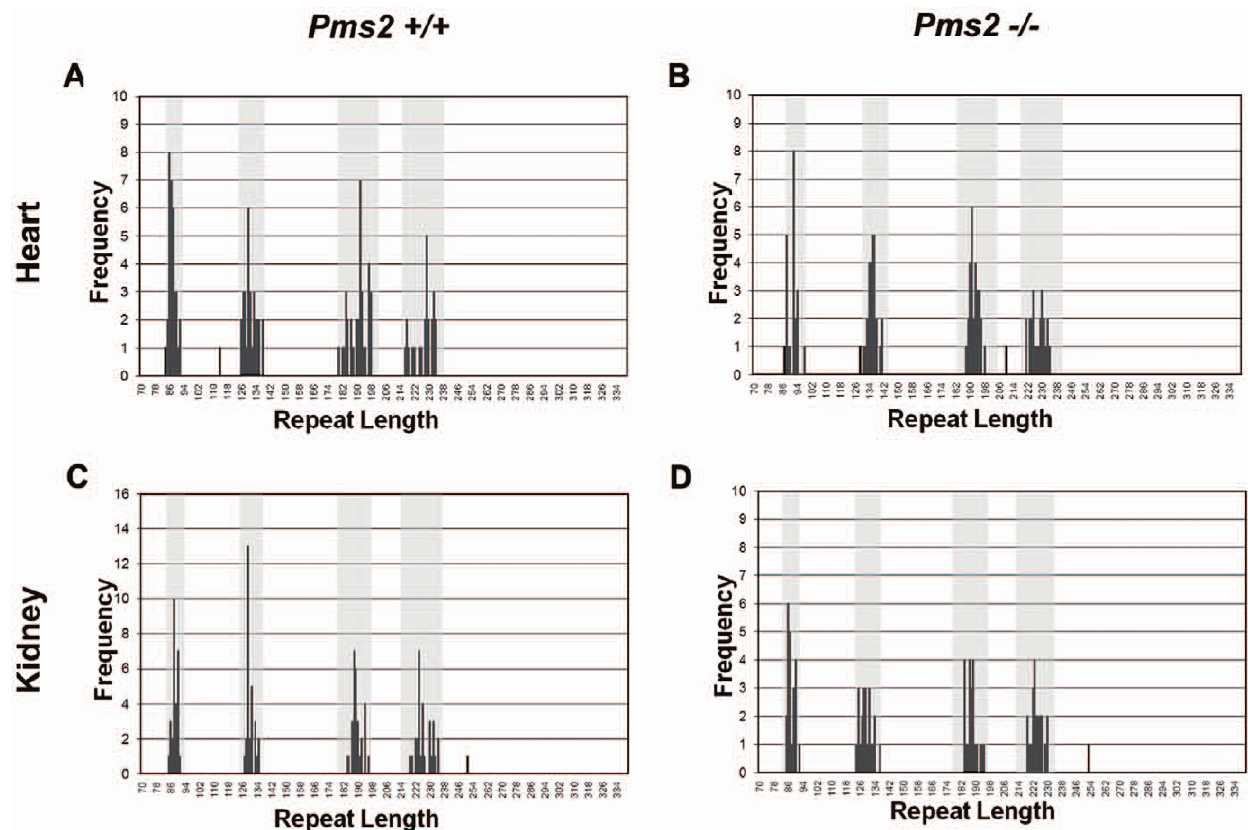
Figure 4. Absence of Pms2 does not affect somatic instability of the (GAA ? TTC) n sequence in non-neuronal tissues. Panels show the distribution of repeat lengths measured in (A,B) heart and (C,D) kidney from (A,C) Pms2 + / + and (B,D) Pms2 2 / 2 littermates. The number of products measured at each repeat length is on the Y-axis. Gray bars represent the length of the progenitor alleles, + / 2 5%. Products that fell outside of these ranges were considered mutations.